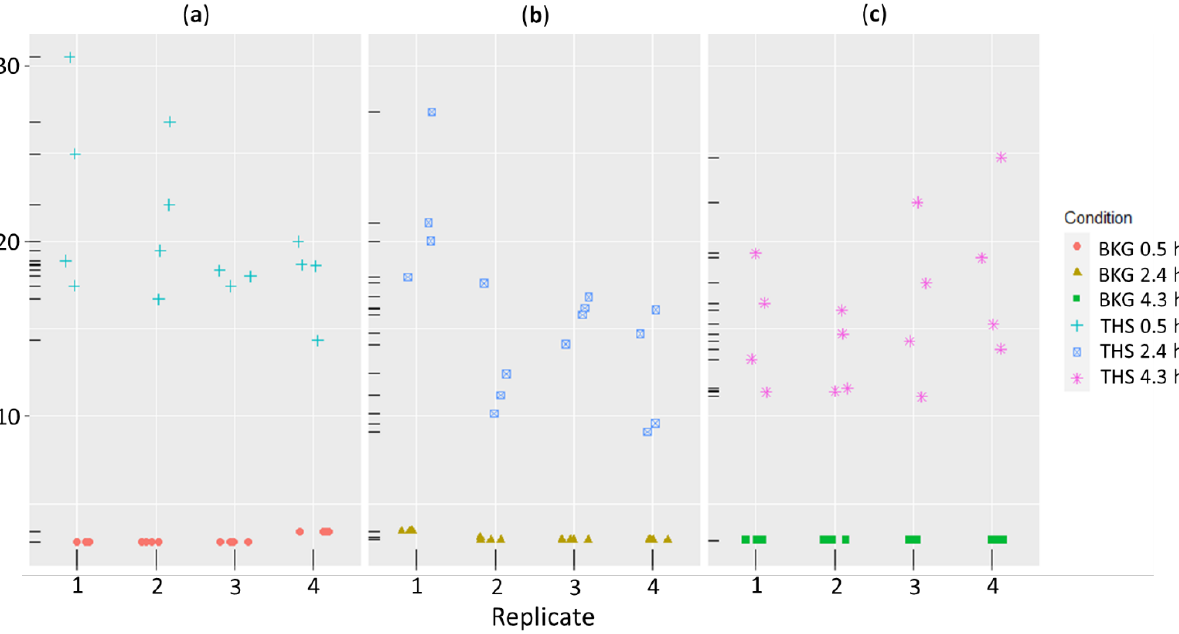
Figure 3. Comparison of the concentrations of airborne glycerin (µg/m 3 ) in the background (BKG) and THS 2.2 use sessions (THS) under simulated ( a ) Residential category III (0.5 h − 1 ), ( b ) Store (2.4 h − 1 ), and ( c ) Restaurant (4.3 h − 1 )